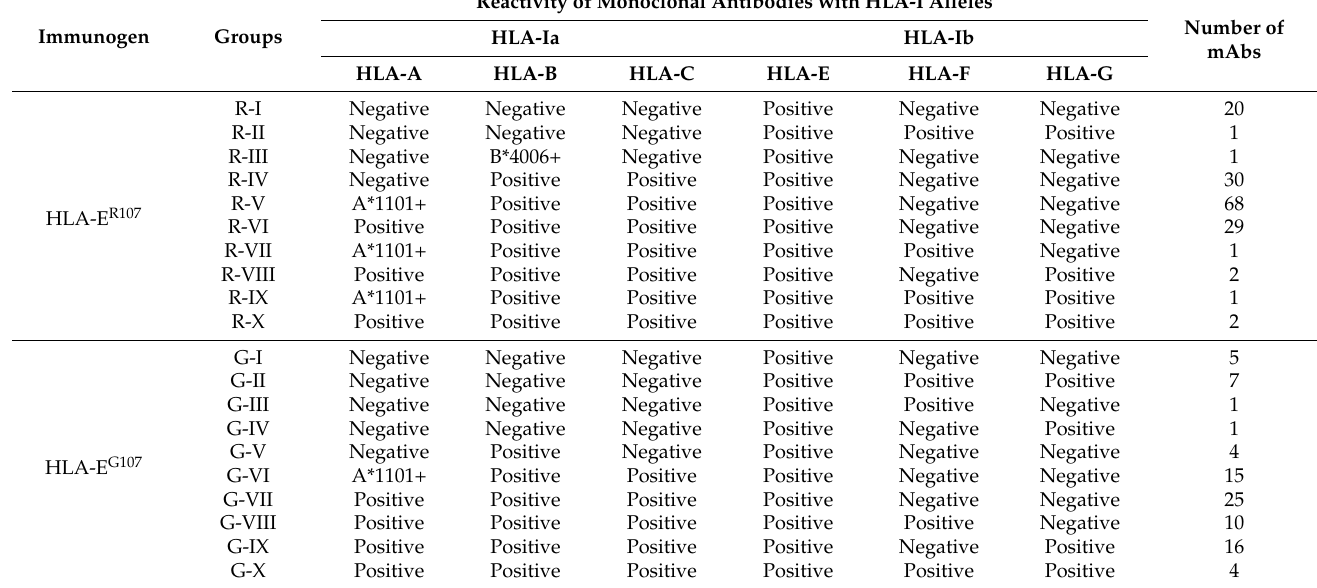
Table 1. Diverse HLA class-I isoform reactivity of the monoclonal antibodies generated against two alleles of recombinant HLA-E heavy